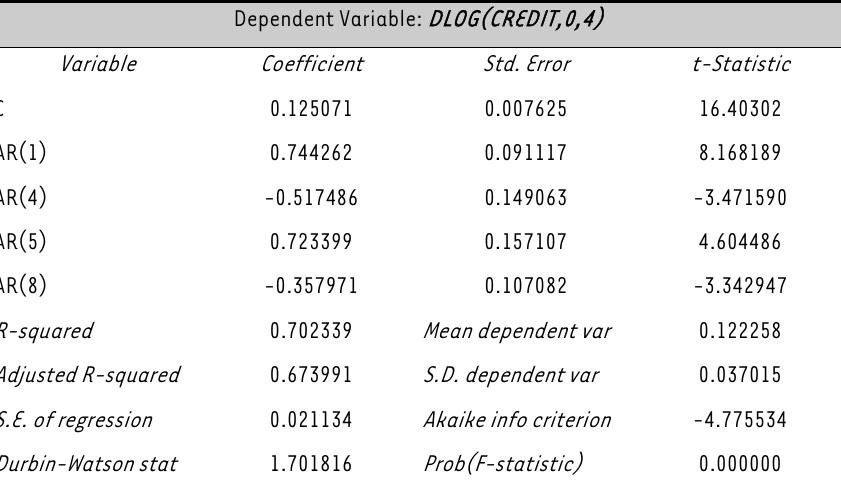
TABLE 3: Results of the Autoregressive Model for CREDIT